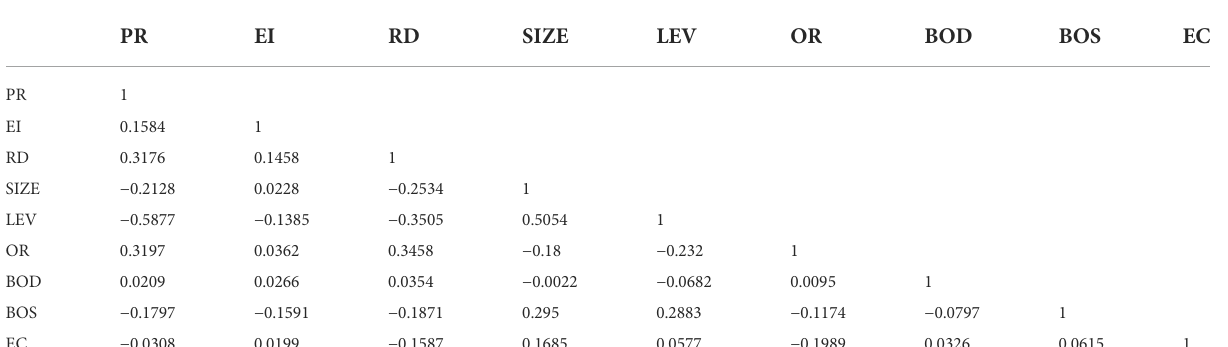
TABLE 2 Pearson correlation matrix.